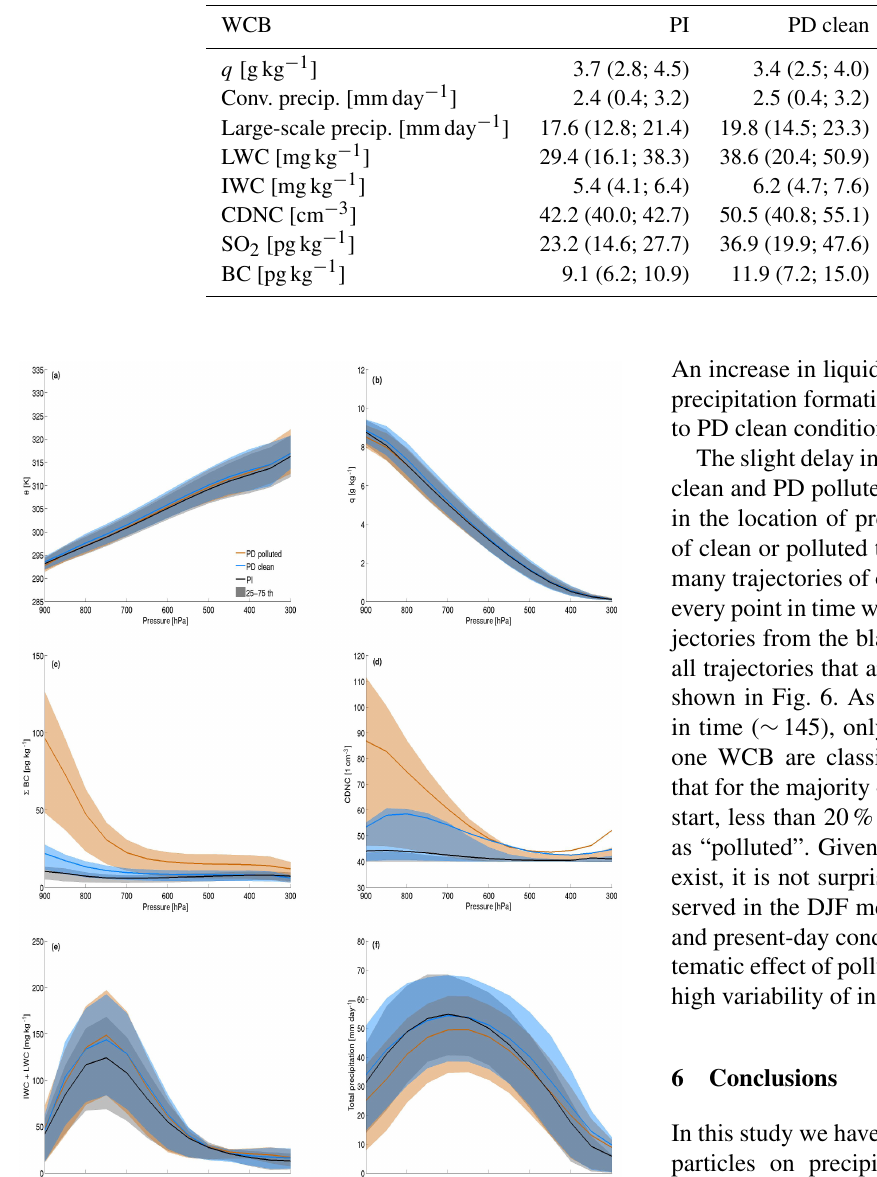
Table 2. Different parameters averaged along all WCB trajectories for the PI, PD clean and PD polluted WCB trajectories. The numbers are the mean, and in brackets the 25th and 75th percentiles.